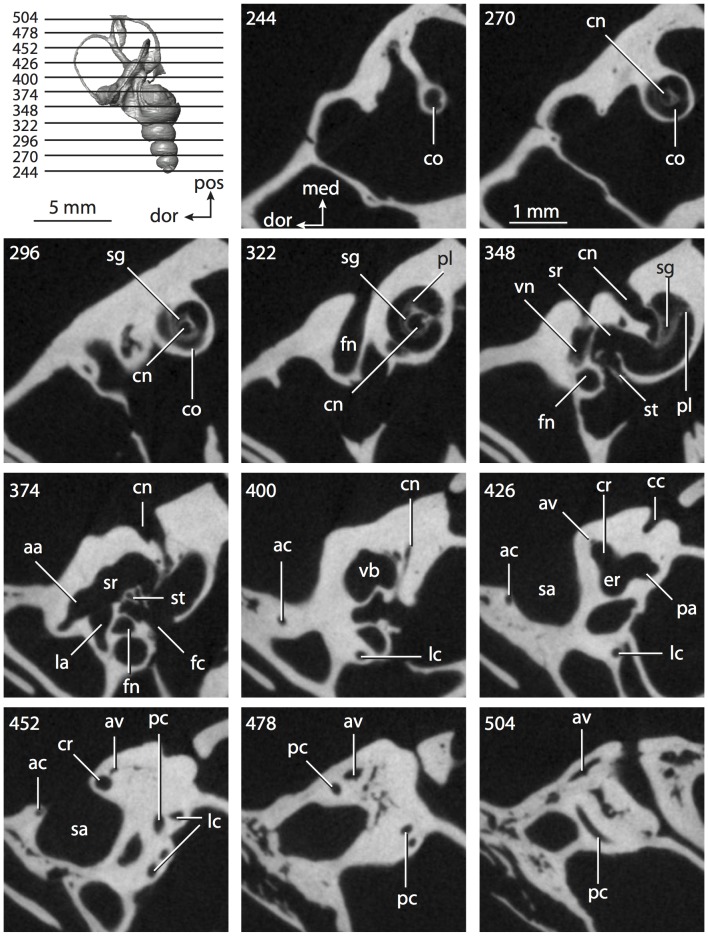
CT slices through ear region ofCavia porcellus.Abbreviations listed at the end of the Materials and Methods section.